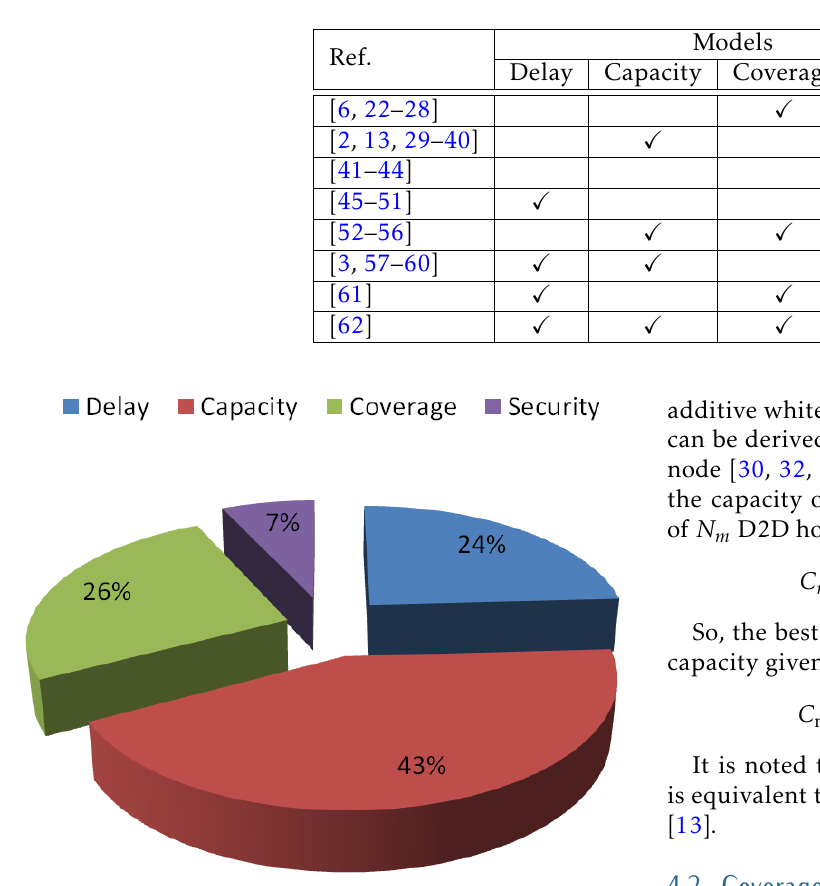
Table 1. D2D MHMP Communications Models